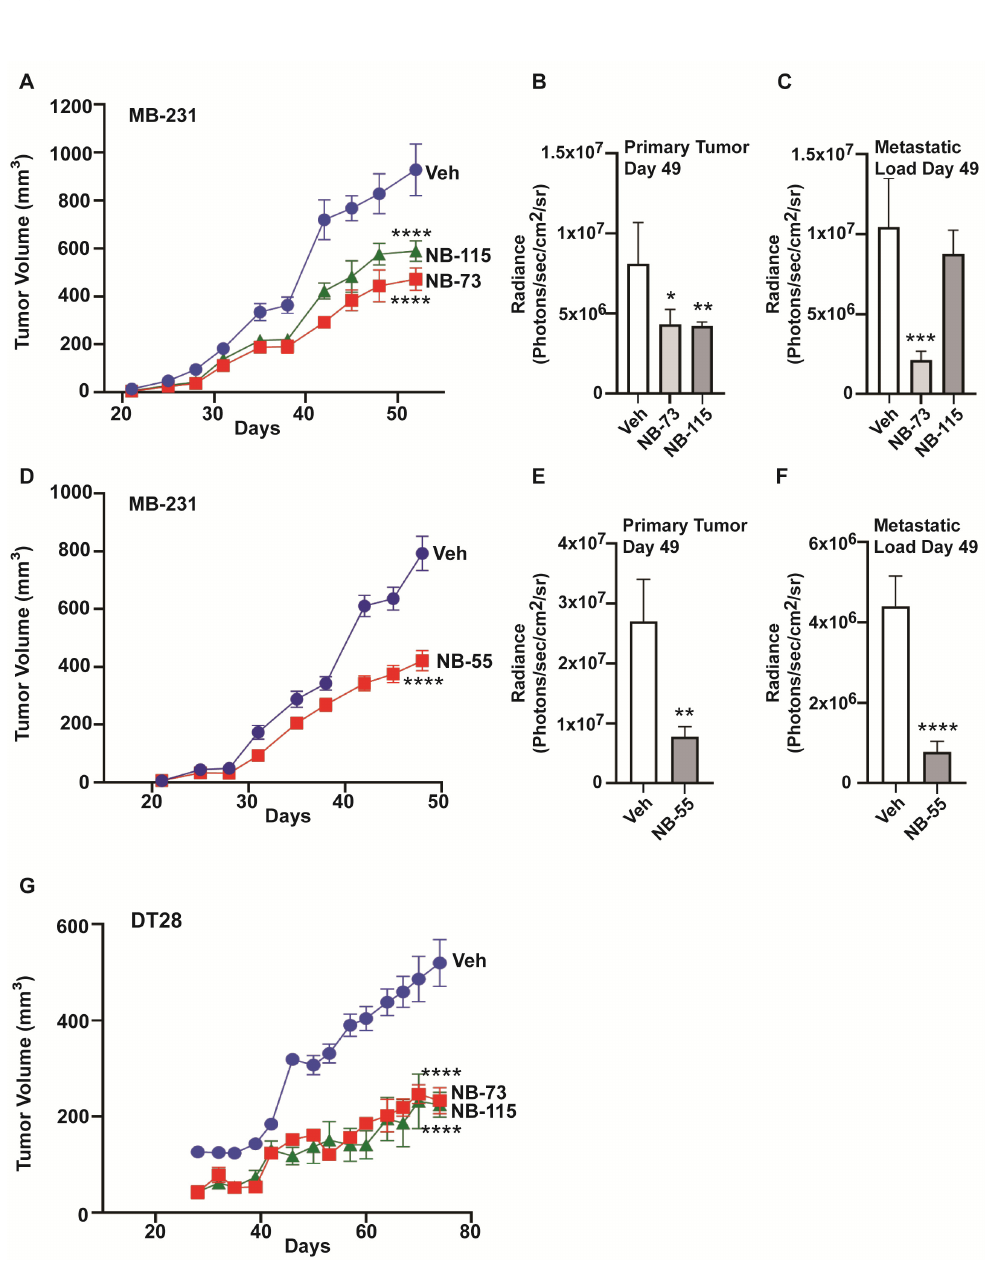
Figure 5. Compounds NB-73, NB-115, and NB-55 suppress TNBC tumor growth and metastasis in vivo, ( A ) Luciferase-expressing MDA-MB-231 cells were inoculated into the mammary fat pad of intact 7 week old NSG mice and mice bearing MDA-MB-231 tumors were dosed with 10 mg/kg of NB-73 or NB-115 or control vehicle by subcutaneous injection as detailed in Methods. Tumor volumes